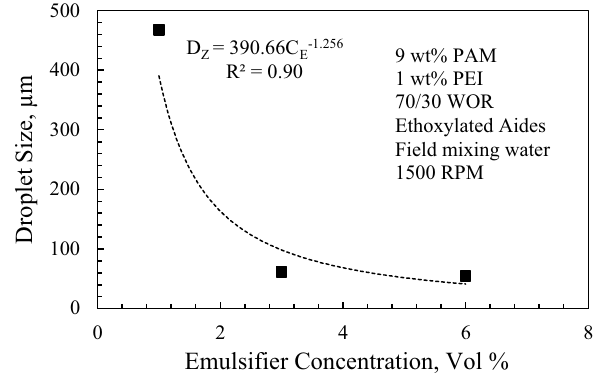
D Z = 390.66C E-1.256 R² = 0.90